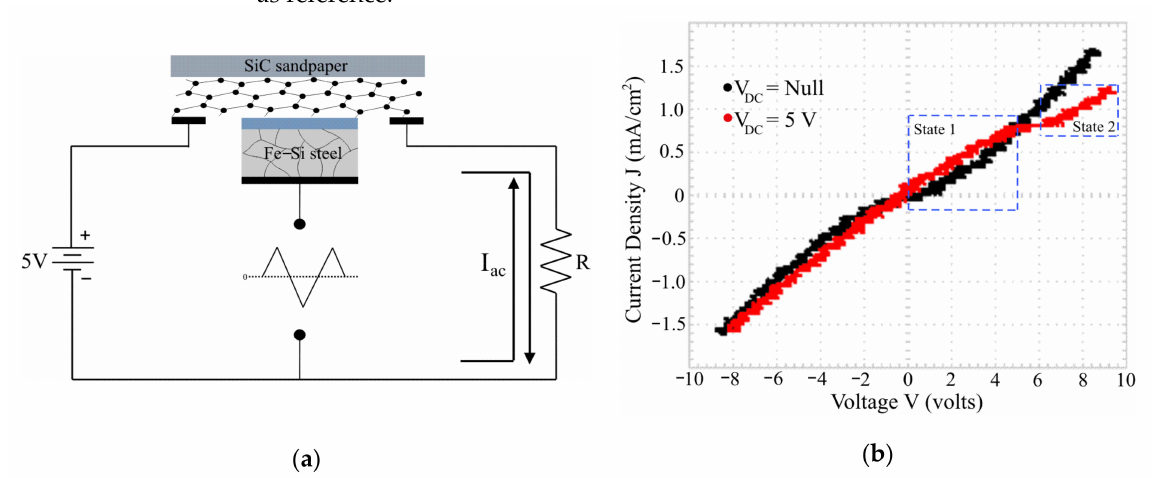
Figure 6. Analog computing inspired by magnetostriction in Fe–Si steel and the disordered structure of the graphite layers. ( a ) Simpler prototype architecture for analog computing; ( b ) current–voltage plot shows two states of different conduction energy as possible arithmetic values.